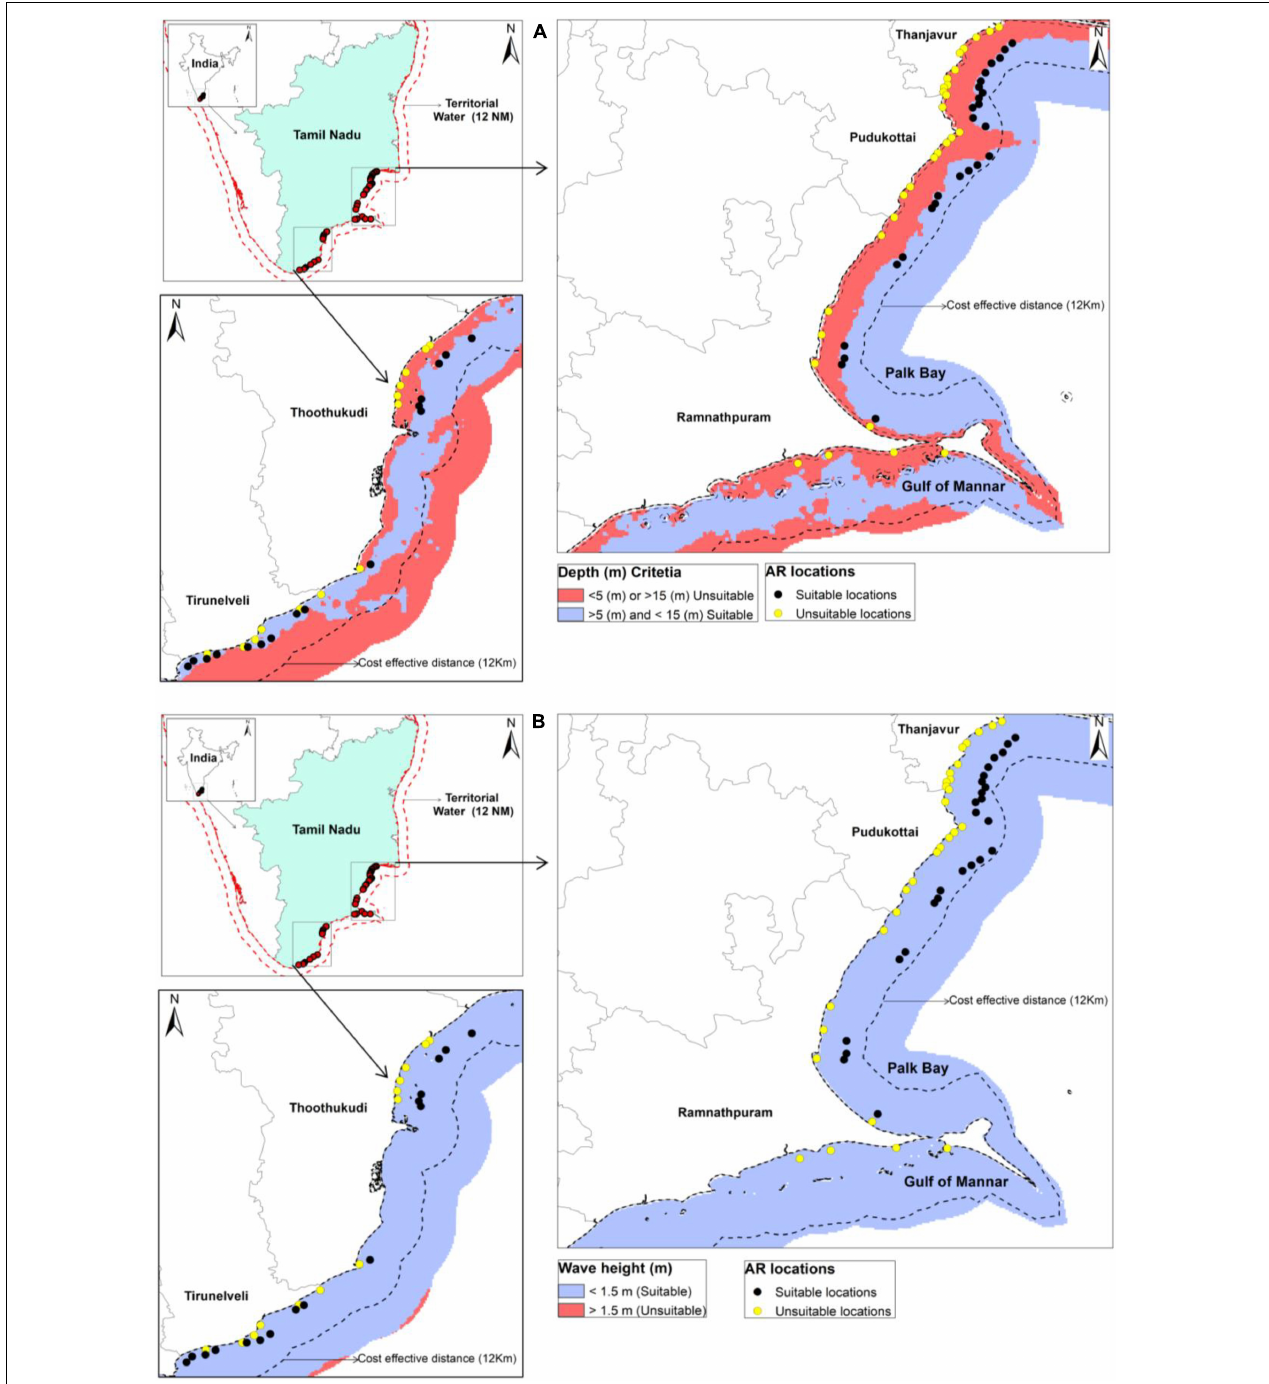
FIGURE 1 | Exclusion mapping model for AR deployment along the Tamil Nadu coast. Data layer indicates unsuitable (red) and suitable (blue) for (A) bathymetry and (B) wave height produced through the GIS reclassification tool.